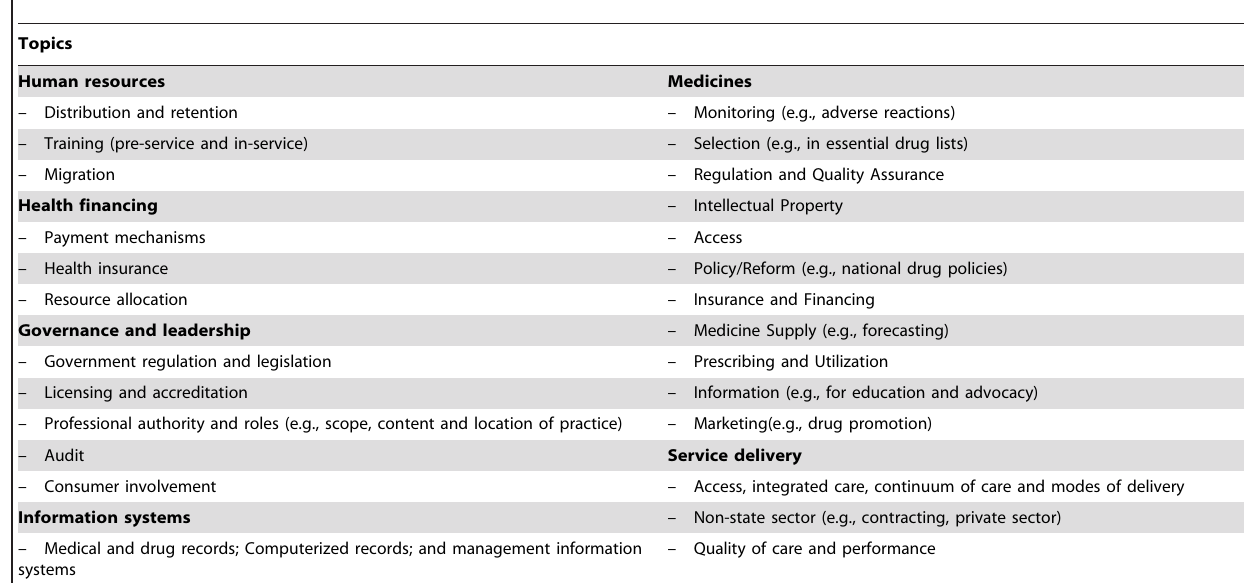
Table 1. Topics explored in the bibliometric analysis by health systems building